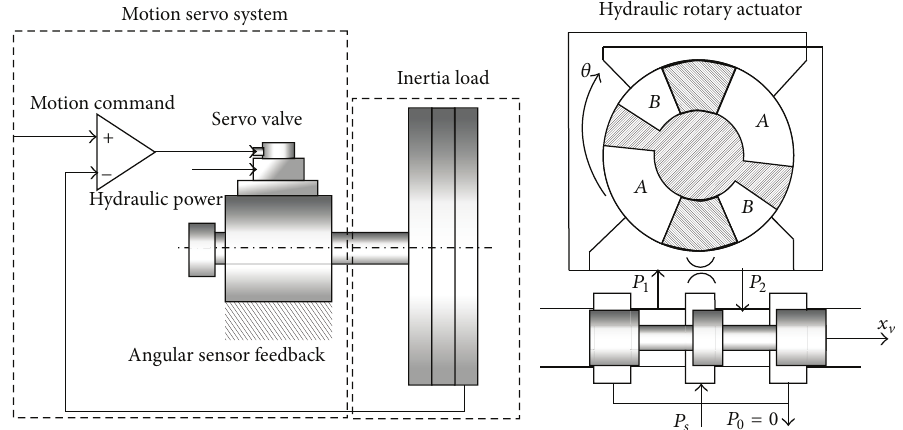
Figure 1: Hydraulic motion servo system and rotary